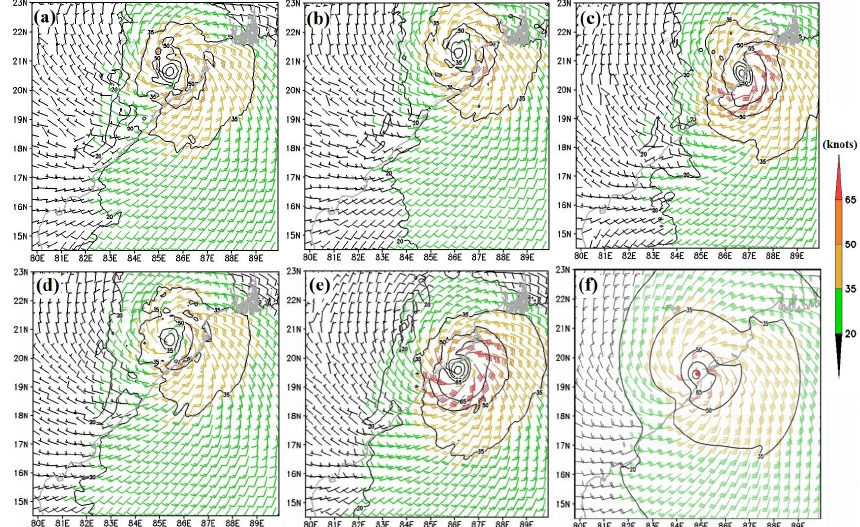
Figure 10. Comparison of wind flow around Phailin at 18:00UTC 12 October 2013 from experiments (a) CTL, (b) VARAMV, (c) VARRAD, (d) VARPREP and (e) VARPREP + RAD with (f) CIRA multi-satellite observations. The contours represent the strength of the horizontal winds in